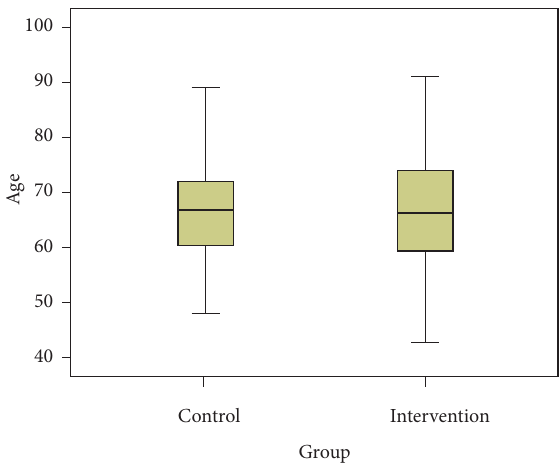
Figure 1: Median, range, and 25th and 75th percentile for age of the two groups.